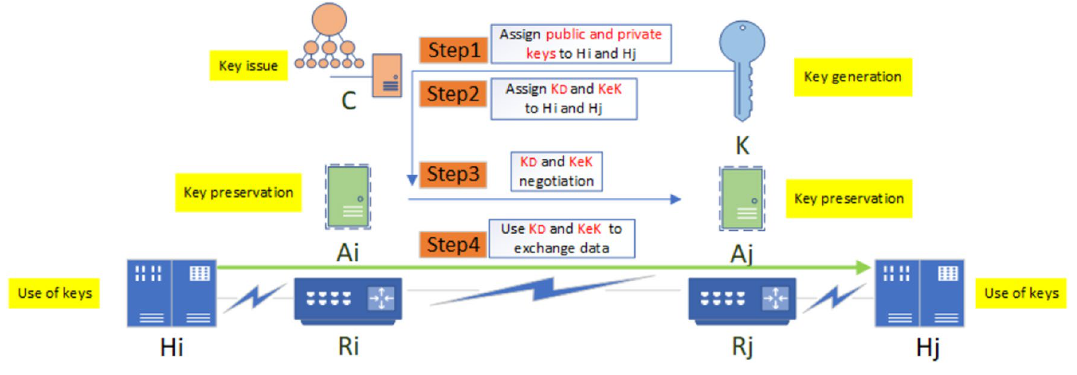
Figure 3. ZbSR key usage